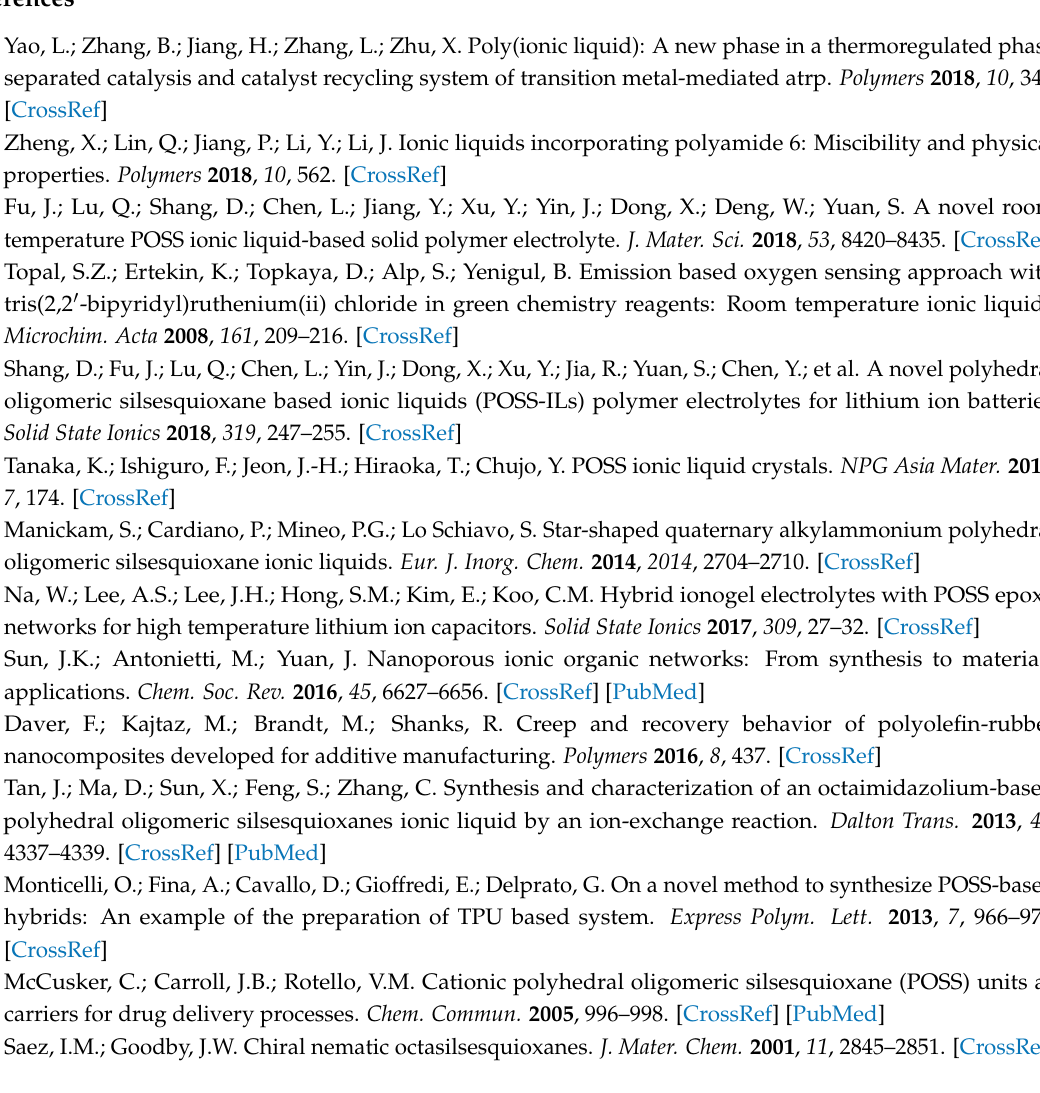
Figure S1: FTIR spectra of IL-POSS-Br and IL-POSS-Cl, Figure S2: 1 H spectra of IL-POSS-Br and HS-POSS. Note: * represents solvent peaks, Figure S3: 1 H spectra of IL-POSS-Cl. Note: * represents solvent peaks, Figure S4: 13 C spectra of IL-POSS-Br and IL-POSS-Cl. Note: * represents solvent peaks, Figure S5: 29 Si spectrum of IL-POSS-Br, Figure S6: HRMS spectra of IL-POSS-Br and IL-POSS-Cl, Figure S7: XRD spectra of IL-POSS-Br and IL-POSS-Cl, Figure S8: TGA curves of IL-POSS-Br and IL-POSS-Cl, Figure S9: DSC curves of IL-POSS-Br and IL-POSS-Cl, Figure S10: Contact angles (CA) of IL-POSS-Br and